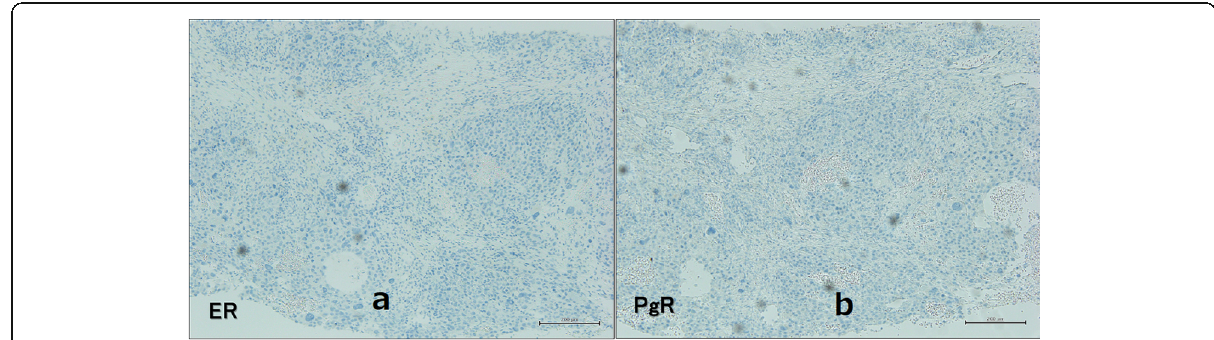
Fig. 4 Imunohistochemical images of the breast tumor. Legend: Immunohistochemical images showed negative results for estrogen receptor ( a ) and progesterone receptor ( b